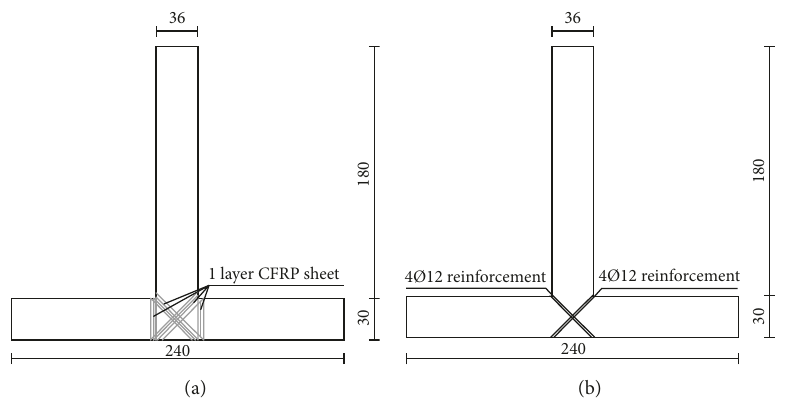
Figure 4: Schematic presentation of strengthening techniques: (a) Sample 1 and (b) Sample 2.